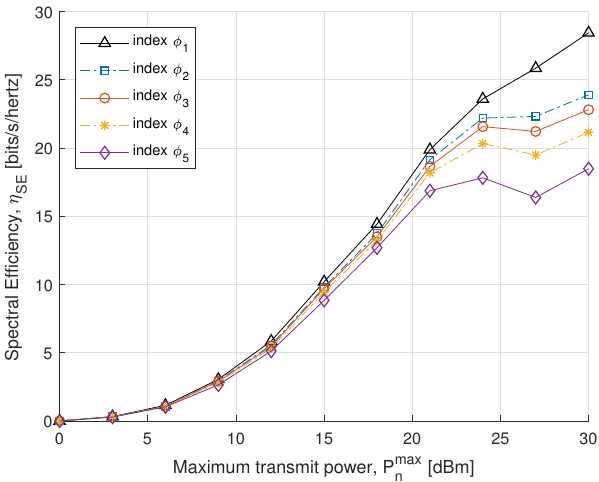
Figure 5. SE vs. transmit